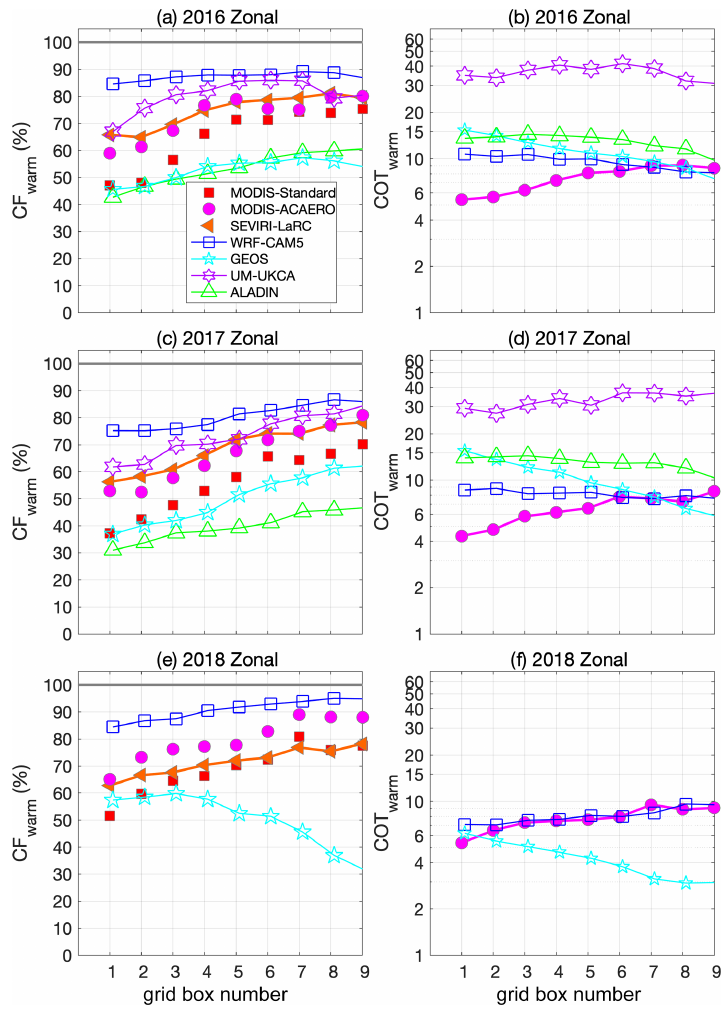
Figure 25. As in Fig. 23 but for the zonal transects in 2016 (a, b) , 2017 (c, d) , and 2018 (e, f)